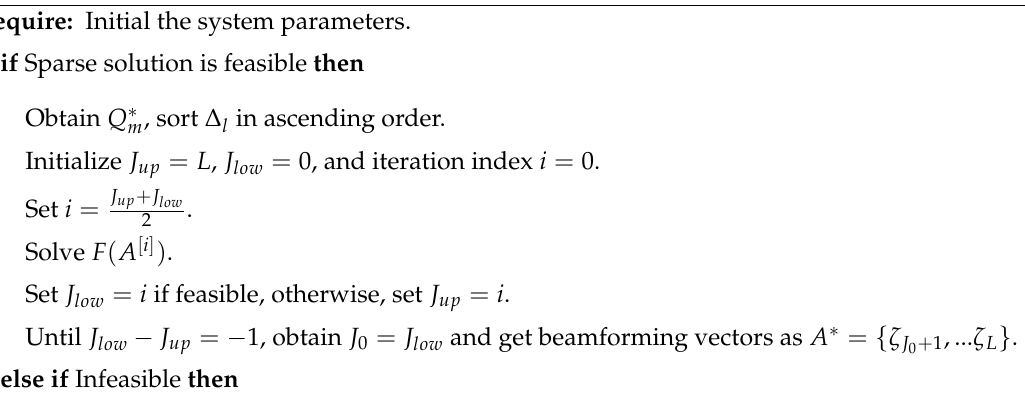
Algorithm 1: Power Control of Network.